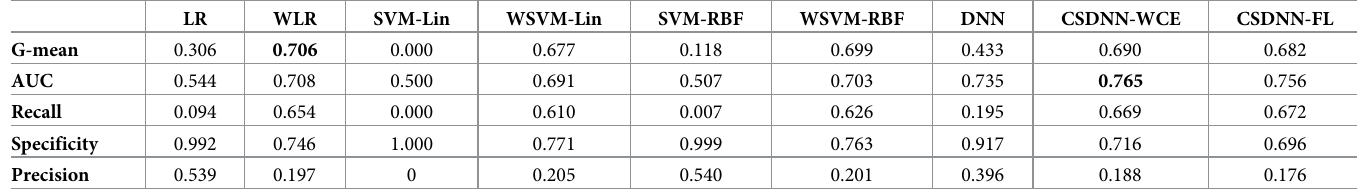
Table 18. Comparative results of CSDNN-WCE and CSDNN-FL against Logistic Regression (LR), Weighted LR, Support Vector Machine (SVM-Lin), Weighted SVM-Lin (WSVM-Lin), SVM with Radial Basis Function (SVM-RBF), Weighted SVM-RBF (WSVM-RBF), and DNN using MOMI data. The highest average G-mean and AUC values are denoted in